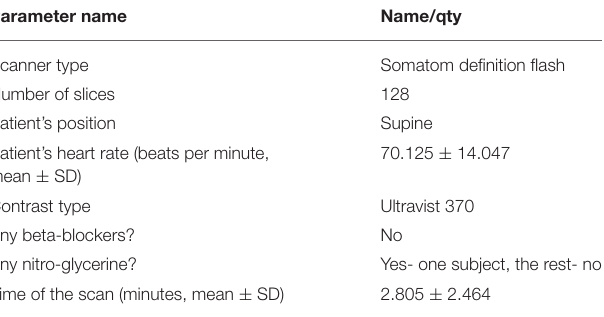
TABLE 1 | CCTA data acquisition.